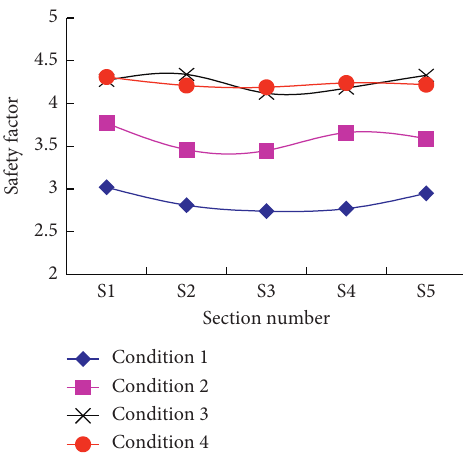
Figure 9: Minimum safety factor. Table 6: Minimum safety factor and antiseismic